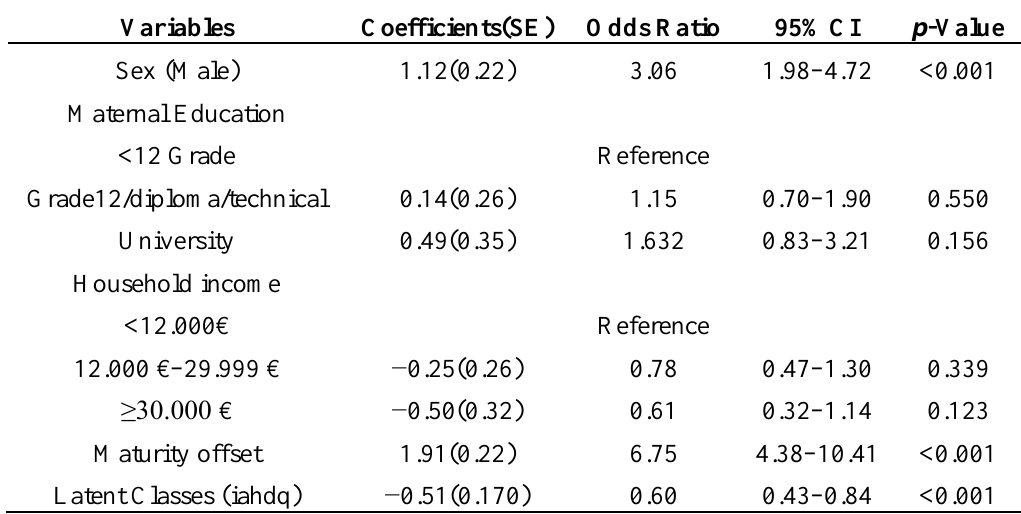
Table 5. Associations (coefficients, standard errors ‡, OR and 95%CI) between biological, socio-demographic characteristics, latent classes and BMI